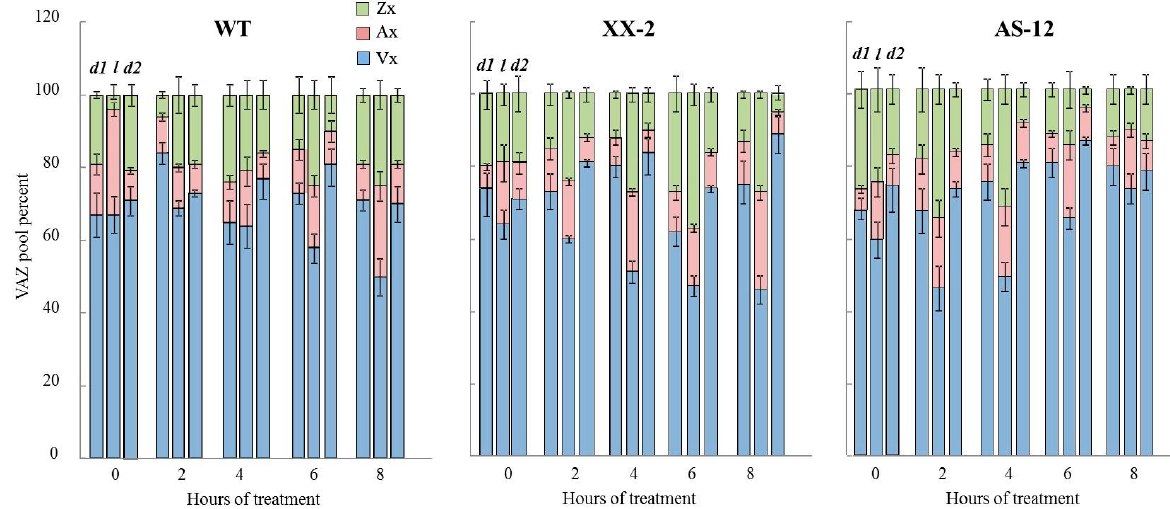
Figure 5. Relative percentage of xanthophylls cycle pigments in leaves of WT, XX-2 and AS-12 Arabidopsis thaliana plants grown at 90 µ mol m − 2 s − 1 , i.e., 0 h, and after 2–8 h of moderately high light (MHL; at 400 µ mol m − 2 s − 1 ): d1 —after 1 h of darkness (dark1), l —after 1 h of high light exposure (1000 µ mol m –2 s –1 ) and d2 —after a subsequent 20 h of darkness (dark2). Time (hours of MHL), experimental conditions ( d1, l, d2 ) and genotype were analysed as independent factors. According to factorial ANOVA analysis the effects of the experimental conditions and the genotype are sig- nificant at p ˂ 0.05 (Wilks’s test) and the time effect is significant at p ˂ 0.1 (Wilks’s test).